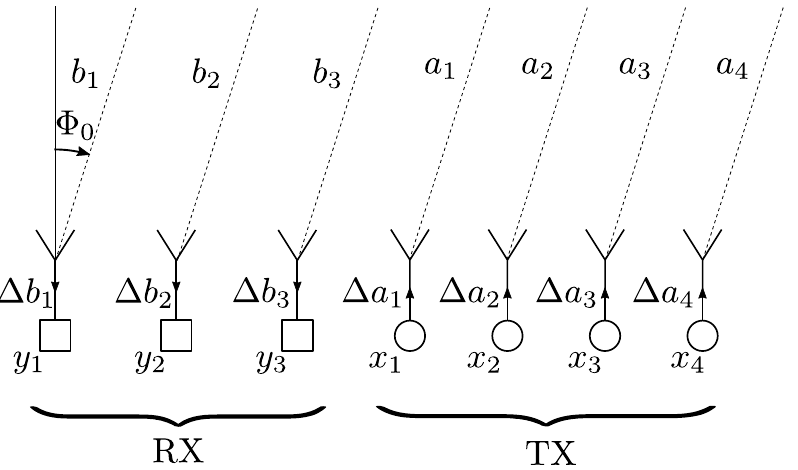
Figure 2. Array configuration with marked unwanted phase shifts ∆ a and ∆ b introduced by the hardware components, respectively, of the transmit and receive channels.